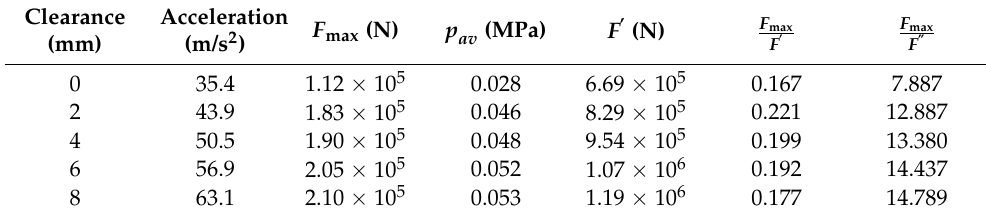
Table 5. The results of the calculation of each variable (8 km/h).